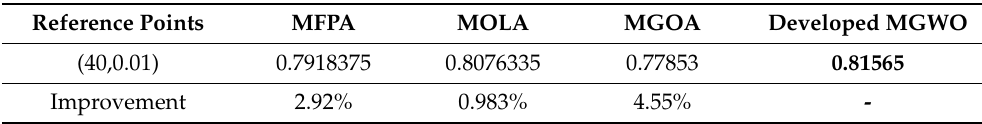
Table 11. Hypervolume indicators of MGWO, MFPA, MOLA, and MGOA for WBD problem under third